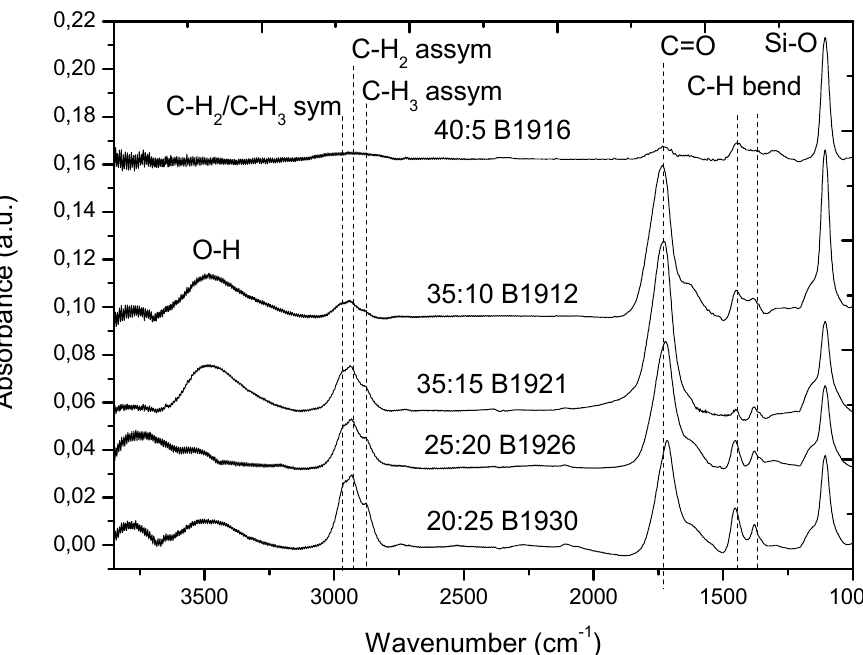
Figure 5. FTIR spectra of Ar/CO 2 /C 2 H 4 layers deposited at different CO 2 :C 2 H 4 ratios onto Si wafers.